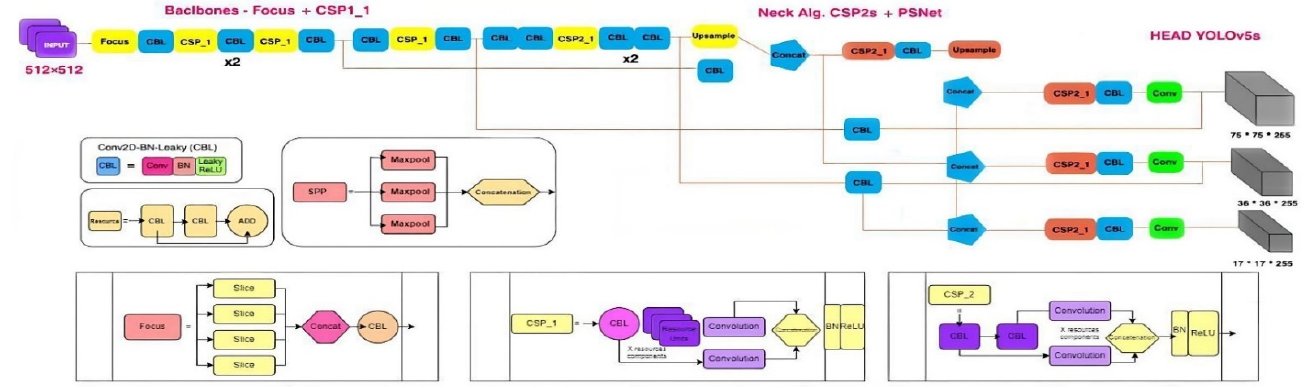
Figure 6. The architecture diagram dedicated to the YOLOv3 network with rigorous adaptations based on the DarkNet-53 backbone.